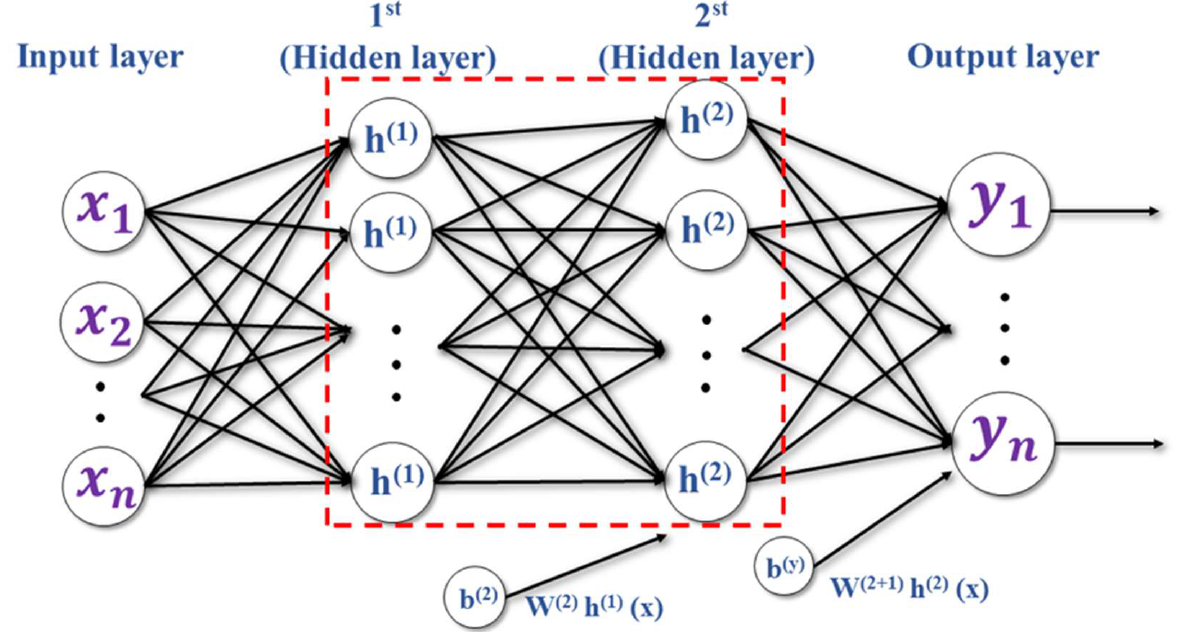
Figure 3. General MLP neural network architecture for the automotive.